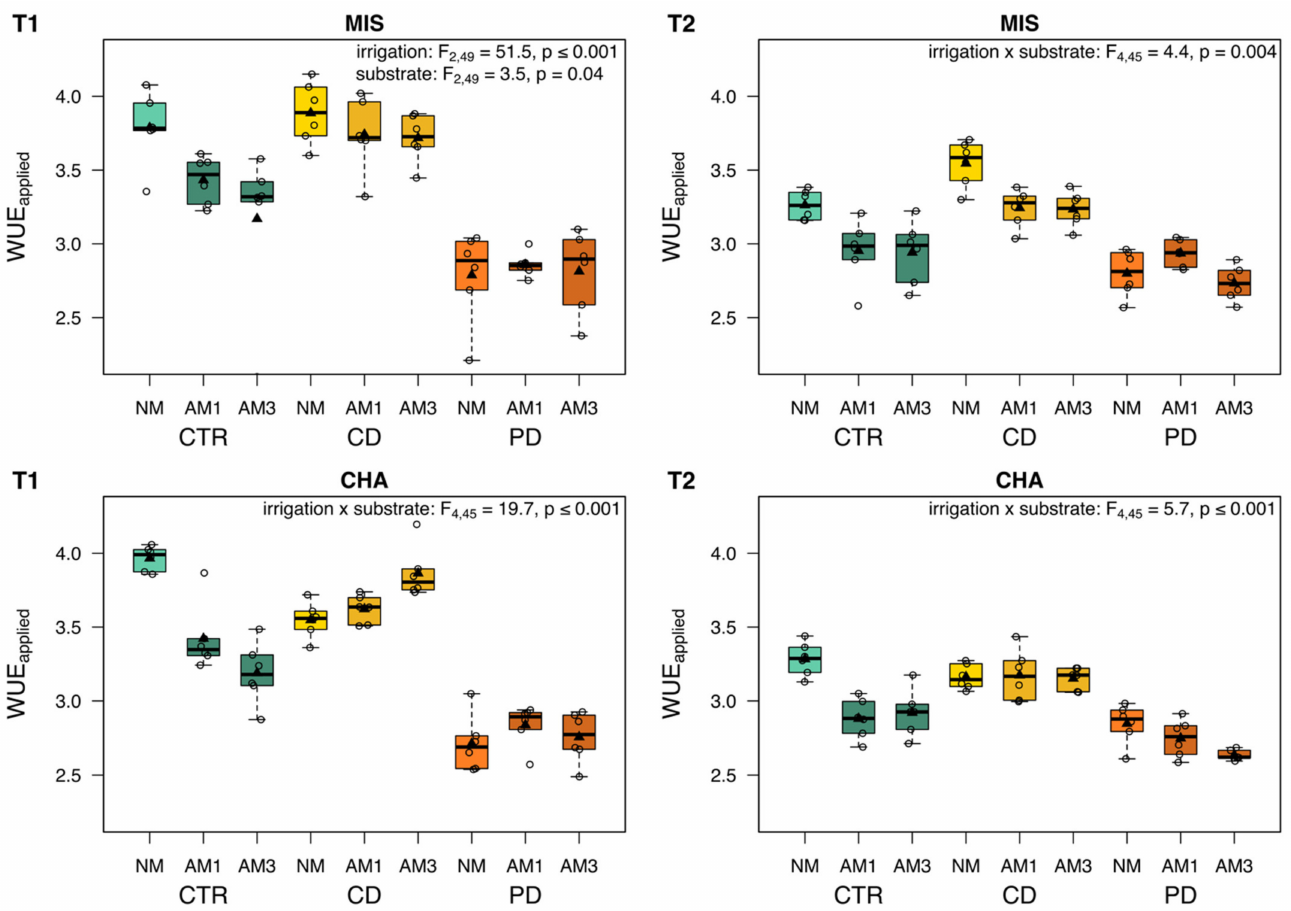
Figure 3. Applied water use efficiency (WUE applied ) of two wheat cultivars [ Triticum aestivum ; Chamsin (CHA), Mistral (MIS)] 67 days (T1) and 113 days (T2) post sowing. Cultivation occurred under different irrigation conditions [control (CTR), continuous drought (CD), and pulsed drought (PD), factor: irrigation]. Plants were either non-mycorrhized (NM), mycorrhized with a single fungus (AM1; Rhizoglomus irregulare ) or with a mixture of three fungi (AM3; R. irregulare , Funneliformis mosseae , F. caledonium ) (factor: substrate). Data are given as box–whisker plots with interquartile ranges (IQR; boxes) including medians (horizontal lines), means (triangles) and whiskers (extending to the most extreme data points with maximum 1.5 times the IQR); individual values are given as open circles. The results of linear models are shown comprising the remaining significant terms after model simplification; n =